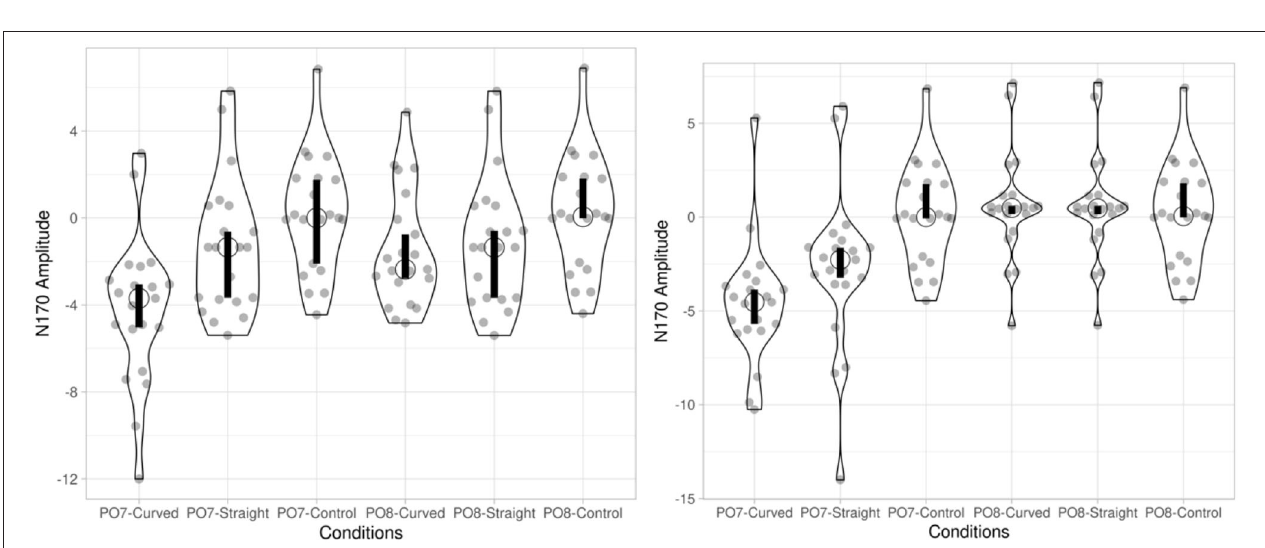
FIGURE 6 | N170 amplitude of normal readers (left) and dyslexic readers (right) in straight, curved and control condition. Open circle indicates the median of the data. Bar chart indicates the 95% confidence interval for each median determined by bootstrapping. (Left: curved: handwriting curved; straight: handwriting straight, control: handwriting control. Right: curved: drawing English curved; straight: drawing English straight; control: drawing English control).